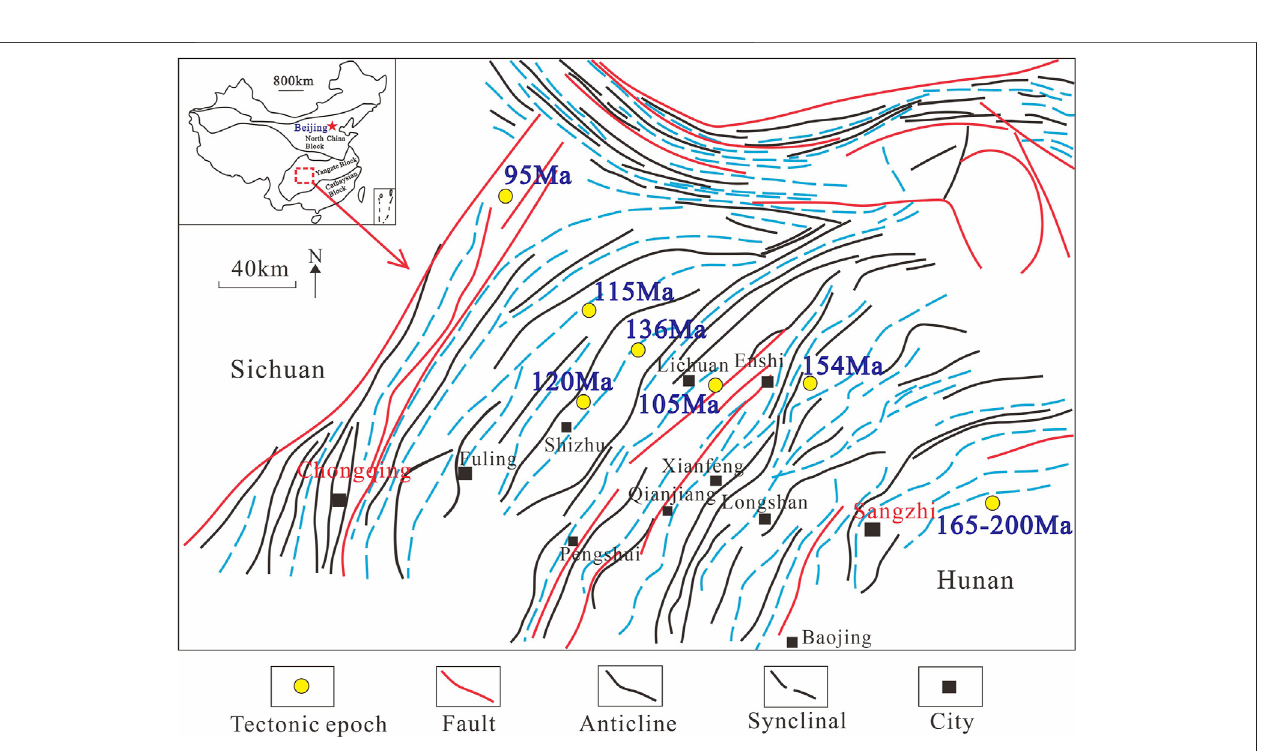
Frontiers in Earth Science |